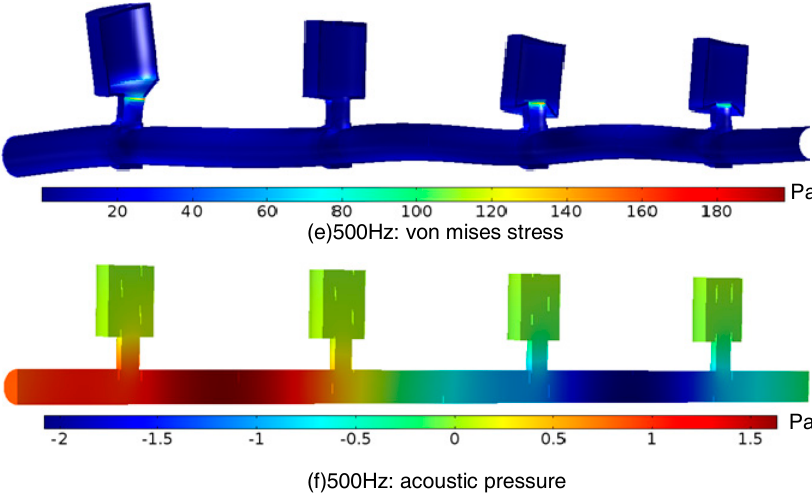
Figure 6. Von misses stress and acoustic pressure field for the seawater pipe system: ( a , c , e ) are respectively corresponding to the von mises stress fields at 235 Hz, 340 Hz and 500 Hz; ( b , d , f ) correspond to the acoustic pressure fields at 235 Hz, 340 Hz and 500 Hz, respectively.